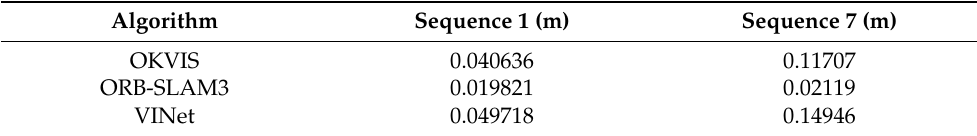
Table 2. Vision–inertial methods positioning accuracy comparison.